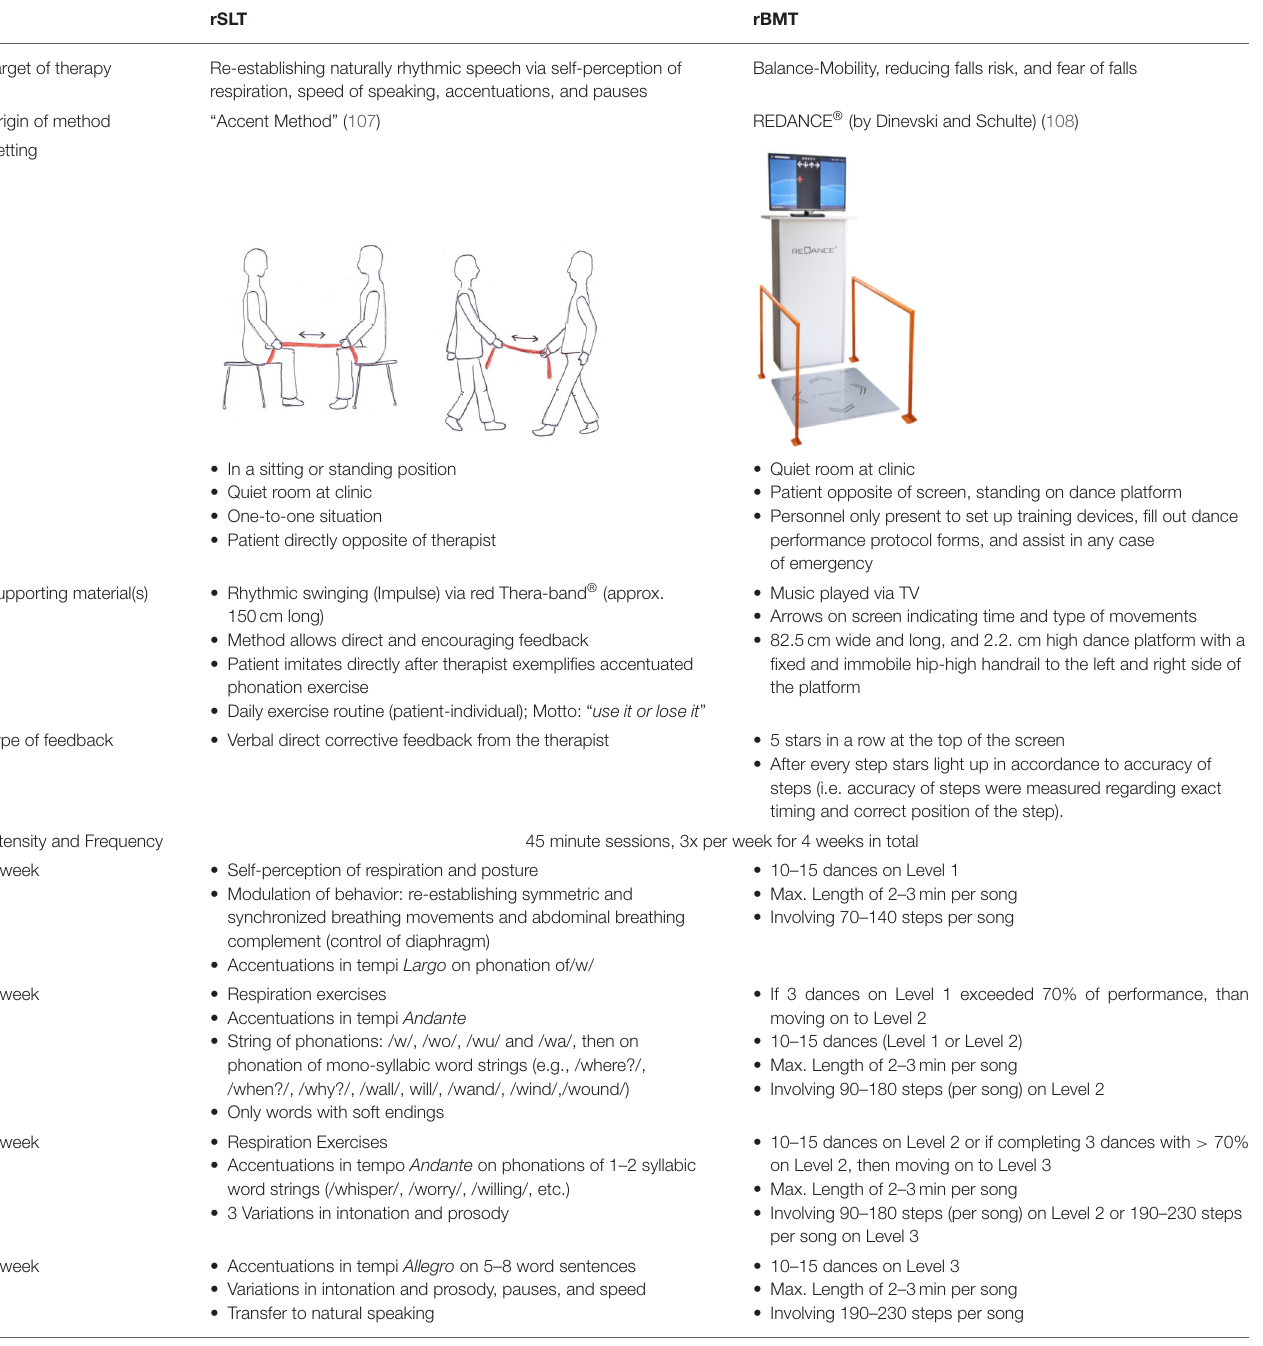
TABLE 2 | Descriptions, outline, and protocols of